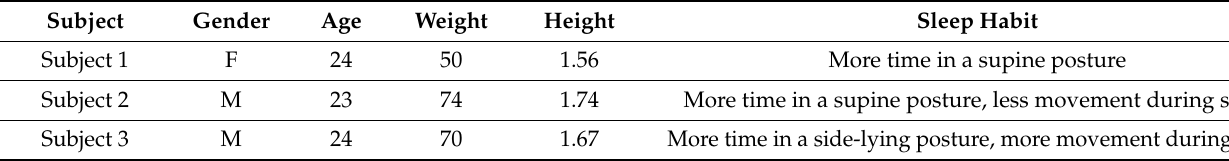
Table 1. The summary of the three subjects.